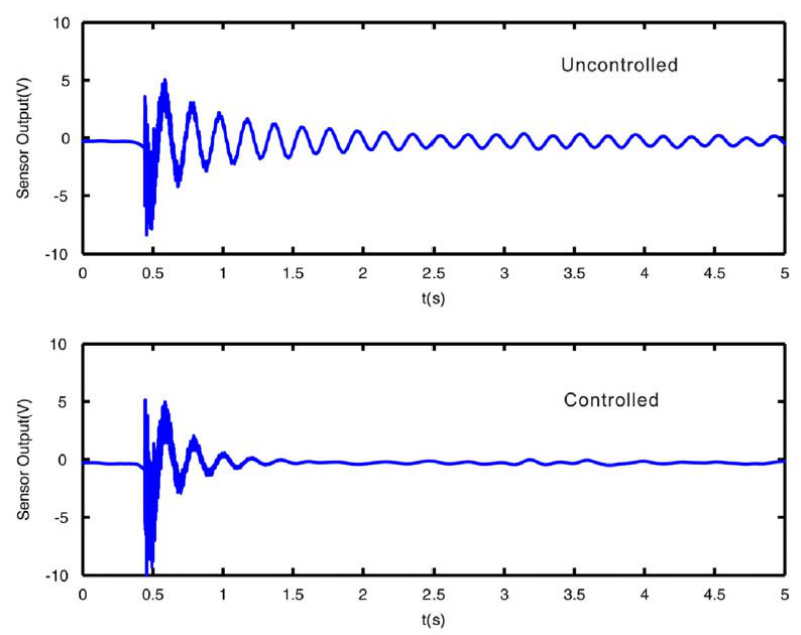
Figure 4. Response of a partially submerged plate due to an impact measured with a PZT